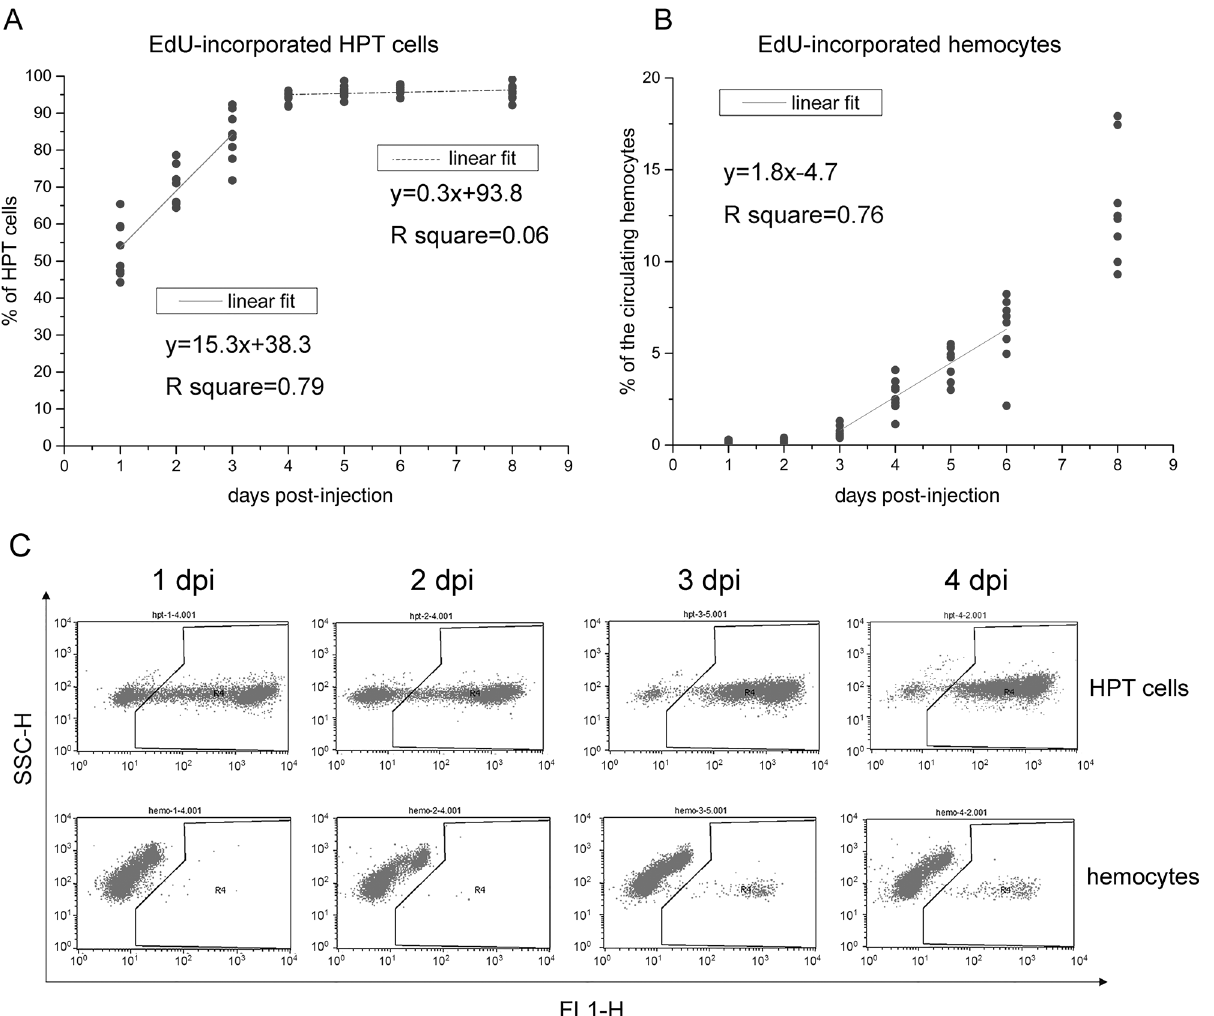
Figure 1. The renewal rate of circulating hemocytes. Crayfish were injected with one dose of EdU. HPT cells and circulating hemocytes were collected at different time points until 8 dpi. After fixation, cells were stained for EdU and analyzed by flow cytometry. Over 10,000 cells were analyzed for each sample. The percentages of EdU-incorporated cells in the HPT ( A ) and circulation ( B ) are shown with percentage-time scatter plots. Eight animals were analyzed at each time point. The relationships between time and EdU incorporation percentages were modeled using linear regression (1 ~ 3 dpi and 4 ~ 8 dpi for HPT cells; 3 ~ 6 dpi for circulating hemocytes). ( C ) Typical FL1-SSC scatterplots obtained in flow cytometry analysis (HPT cells, upper panel; hemocytes, lower panel). Cells in the right region of each plot are